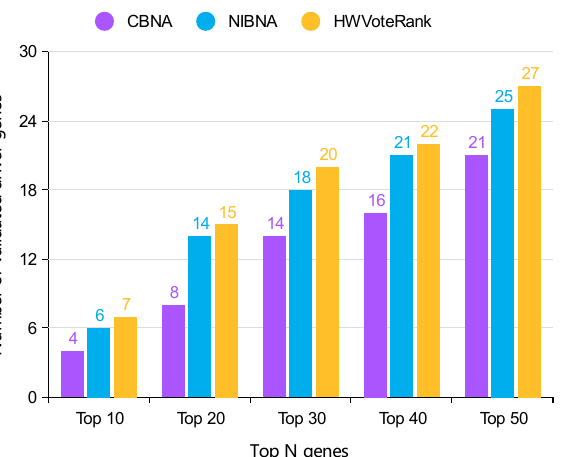
Figure 4. Comparison of the number of confirmed drivers in the top 50 predicted cancer driver of gene with